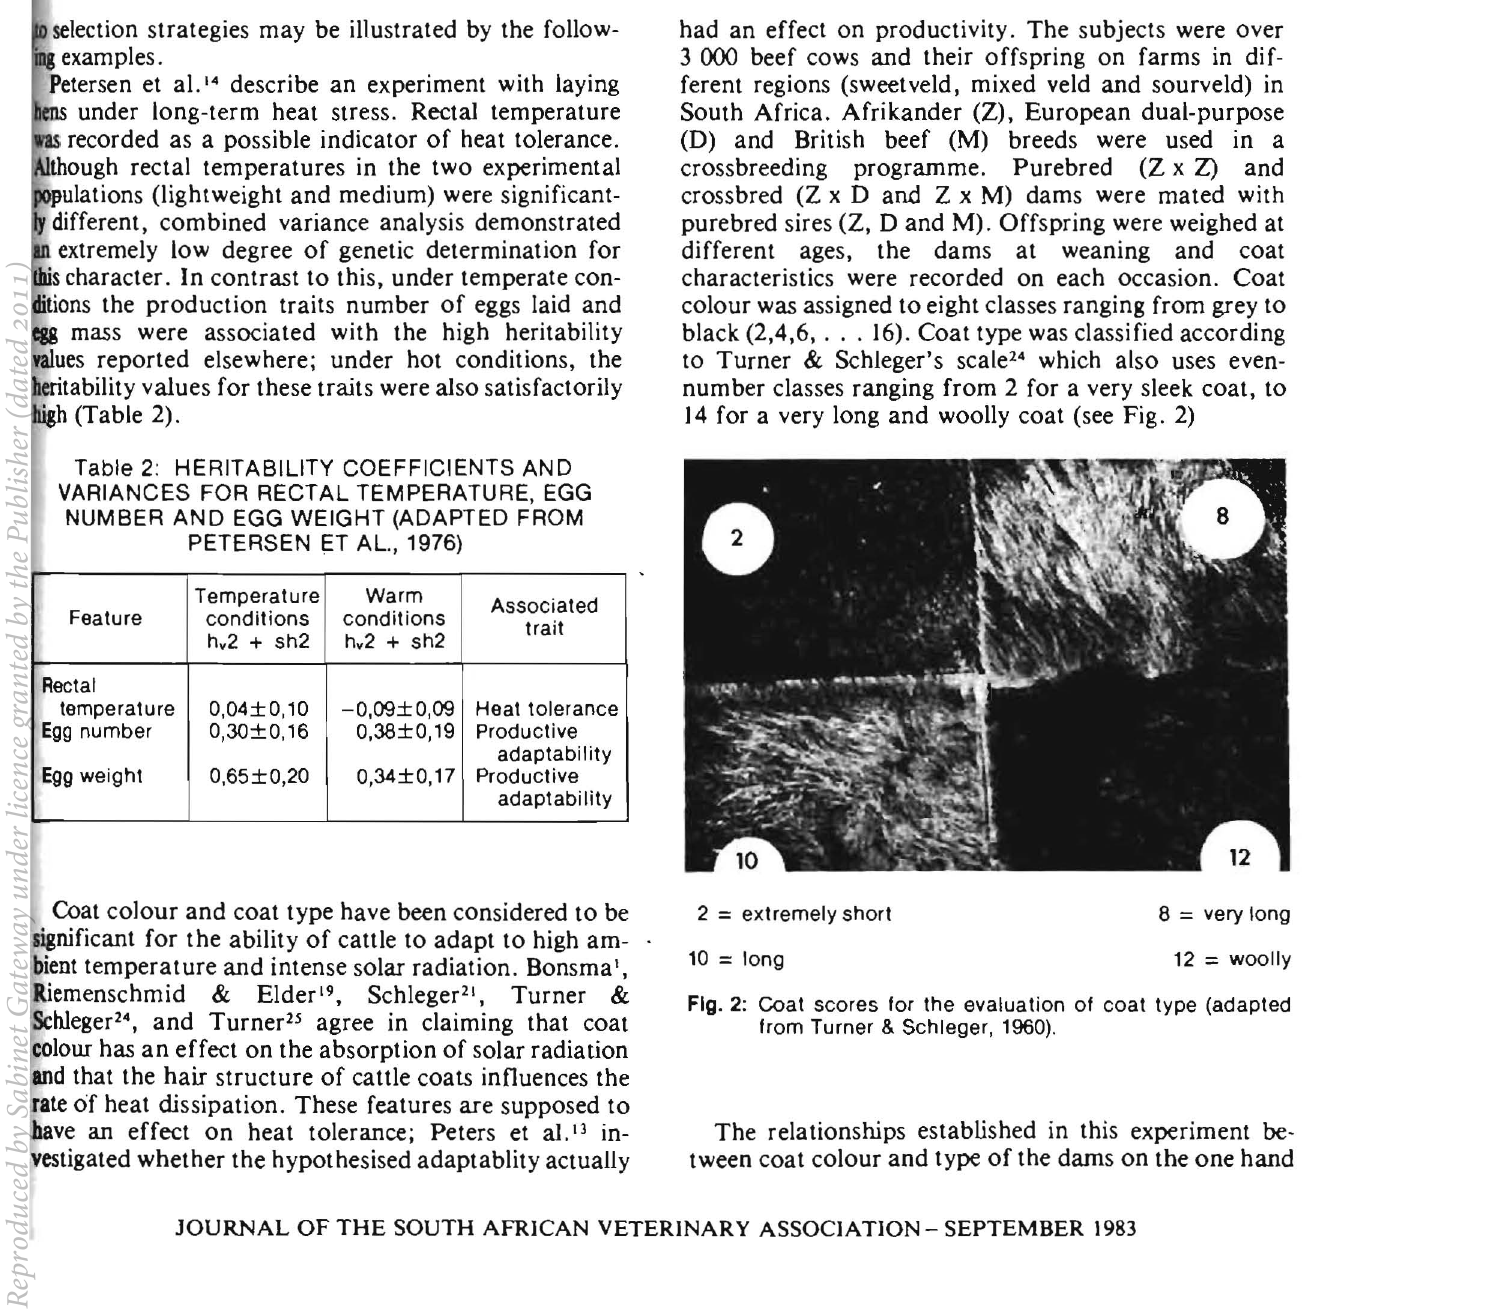
The relationships established in this experiment be tween coat colour and type of the dams on the one